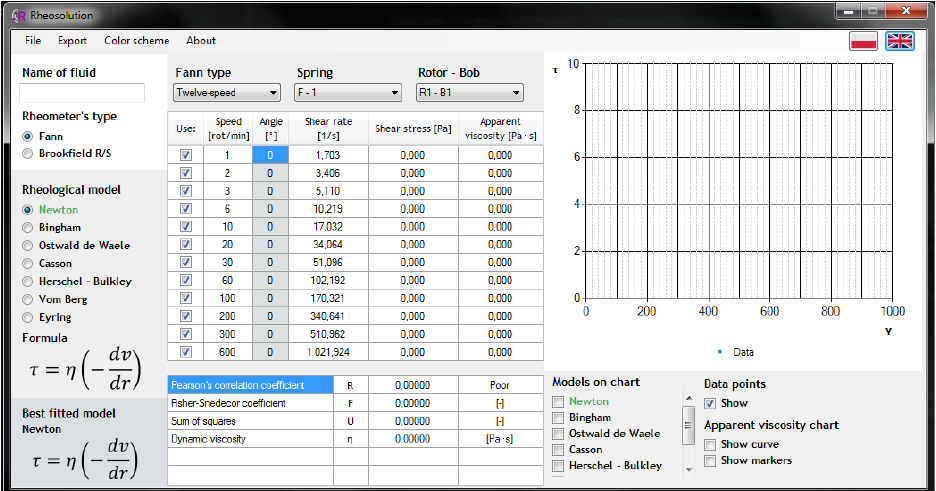
Figure 5. Rheosolution 4.0 interface.